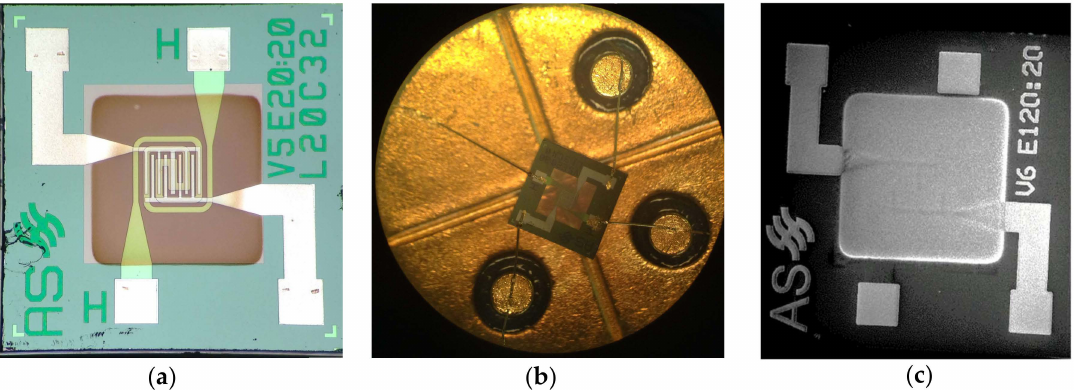
Figure 3. Optical images of WO 3 device as-fabricated ( a ) and mounted with gold wires on TO package ( b ). Electrodes and heating elements are visible through the thin membrane. ( c ) SEM image of SnO 2 device at low magnification (100 ×